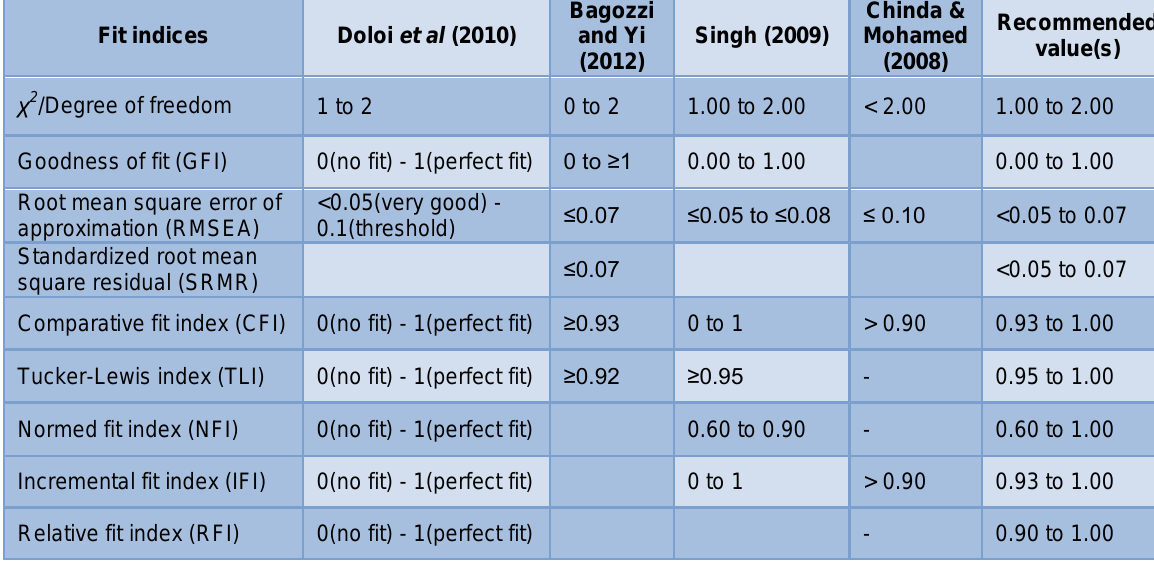
Table 2 Recommended level of Goodness-of-fit (GOF)